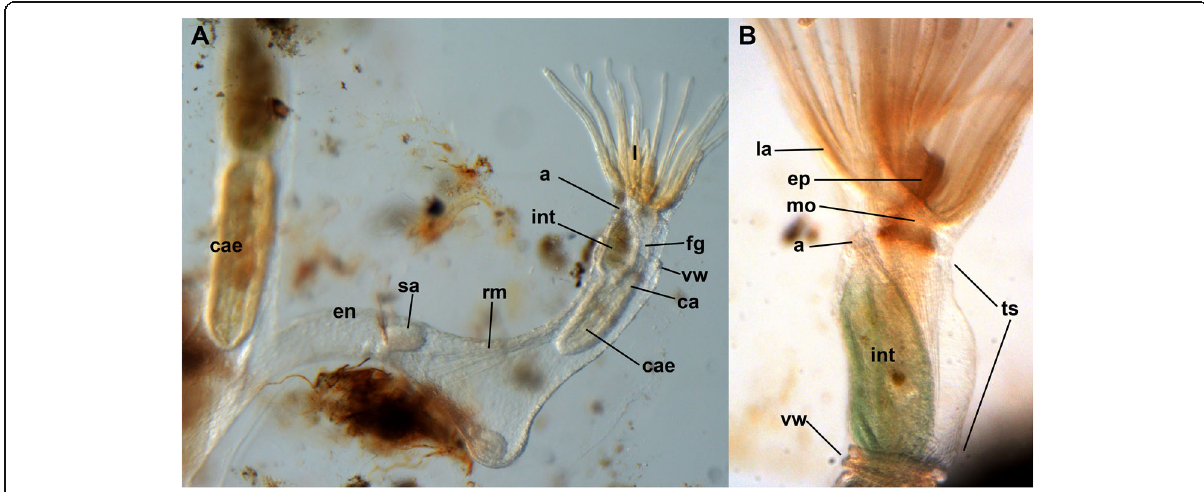
Fig. 1 General overview of Stephanella hina . Live specimens. a Lateral view of two zooids on the budding tip, with a younger zooid on the right and an older zooid on the left. b Detail of a single zooid including several morphological characteristics. Abbreviations: a - anus, ca - cardia, cae - caecum, en - endocyst, ep - epistome, fg - foregut, int - intestine, l - lophophore, la – lophophoral arm, mo - mouth opening, rm. - retractor muscle, sa - statoblast anlage, ts - tentacle sheath, vw - vestibular